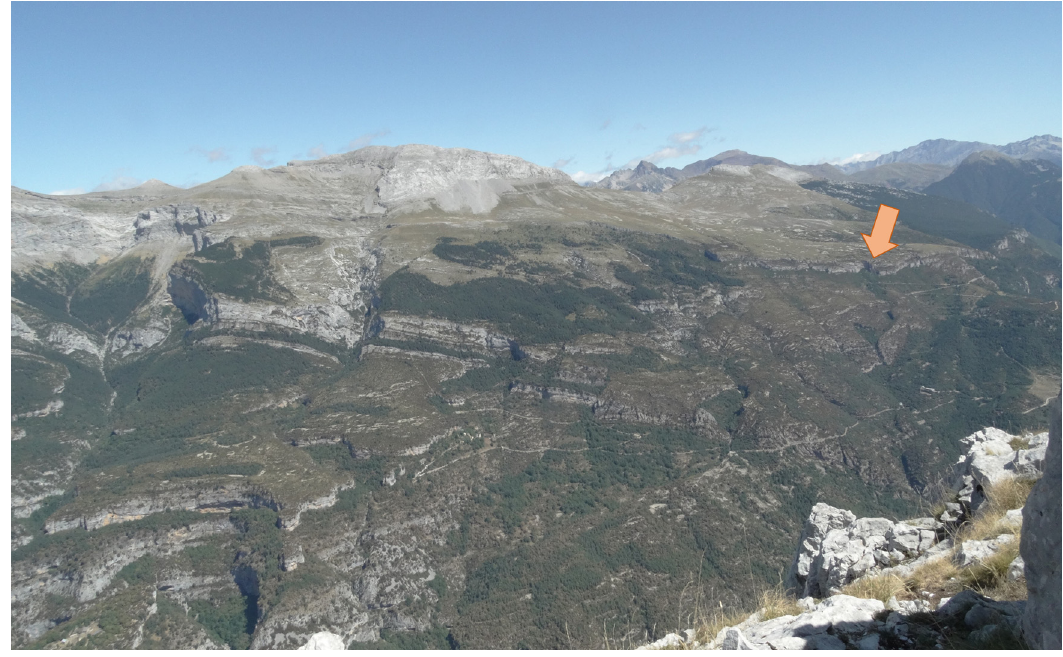
Figure 5: General view of the southern slope of the Sierra de Tucas. The arrow points to the cave of Coro